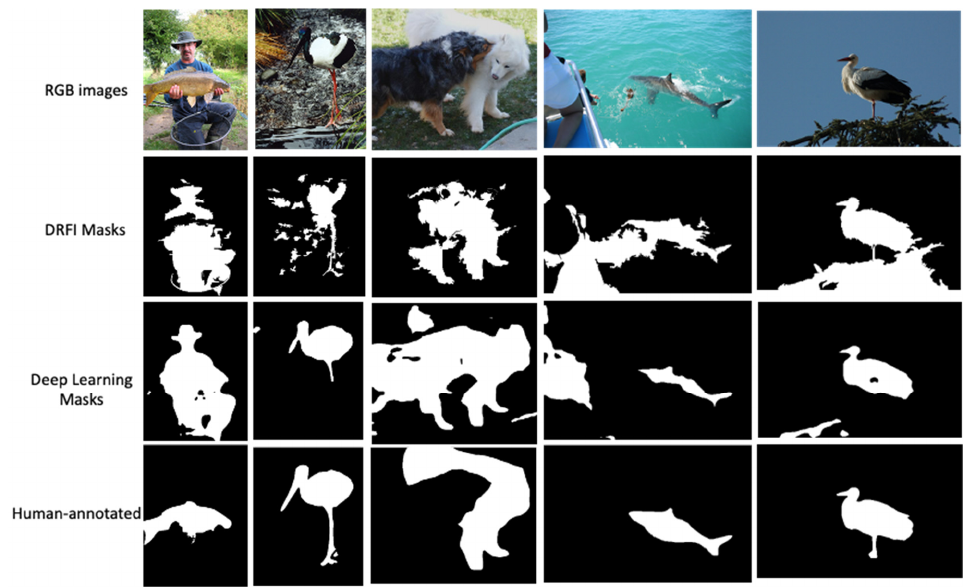
Figure 7. The heuristic binary masks are generated using an unsupervised deep learning encoder with saliency threshold values.